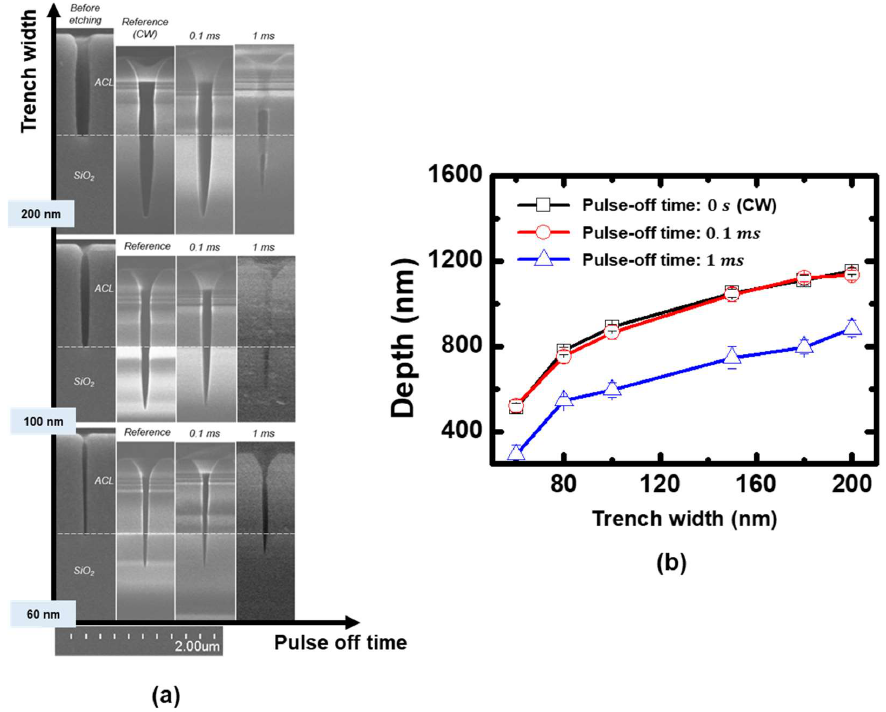
Figure 8. ( a ) Absolute neural species densities, ( b ) electron densities and self-bias voltages, ( c ) cal- culated neutral to ion flux ratios based on the measurement data in the pulse-modulated plasmas with various pulse-off time in C 4 F 8 80%.